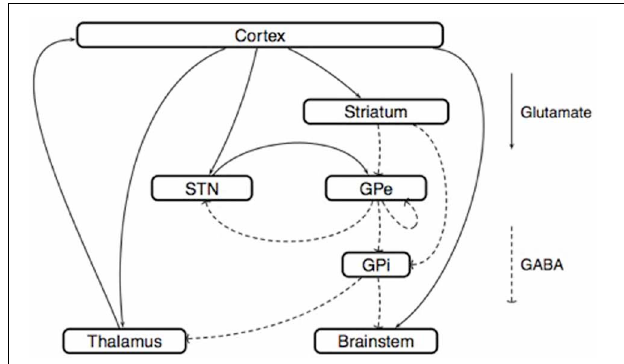
FIGURE 6 | Model of Rubin and Terman. This scheme represents the synaptic interconnections, both within the basal ganglia and between their afferent and efferent anatomical structures. This type of circuit representation has generated several basal ganglia models, both at the microscopic and at the mesoscopic scales. Microscopic models: Neural activity is described at the level of each neuron. Following the approach of Hodgkin and Huxley (1952), the dynamics of the membrane voltage V i ( t ) associated with the i -th neuron is described by a conductance